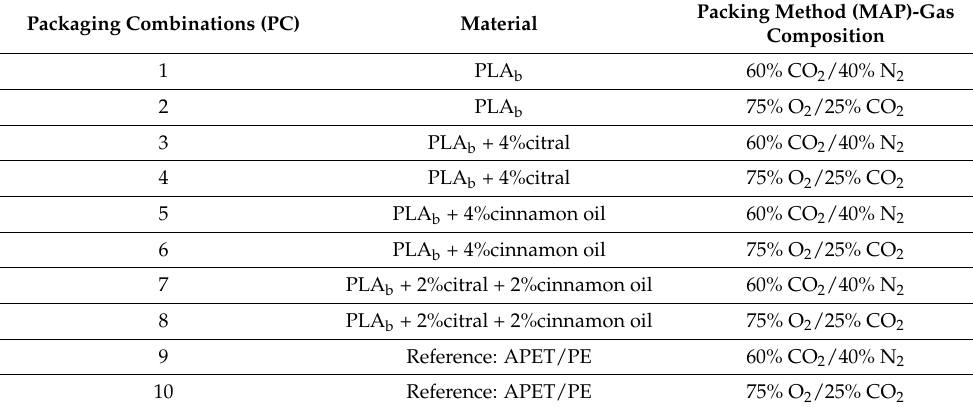
two distinct gas compositions: MAP1 (60% CO 2 /40% N 2 ) and MAP2 (75% O 2 /25% CO 2 ). Packaging Combinations (PC)